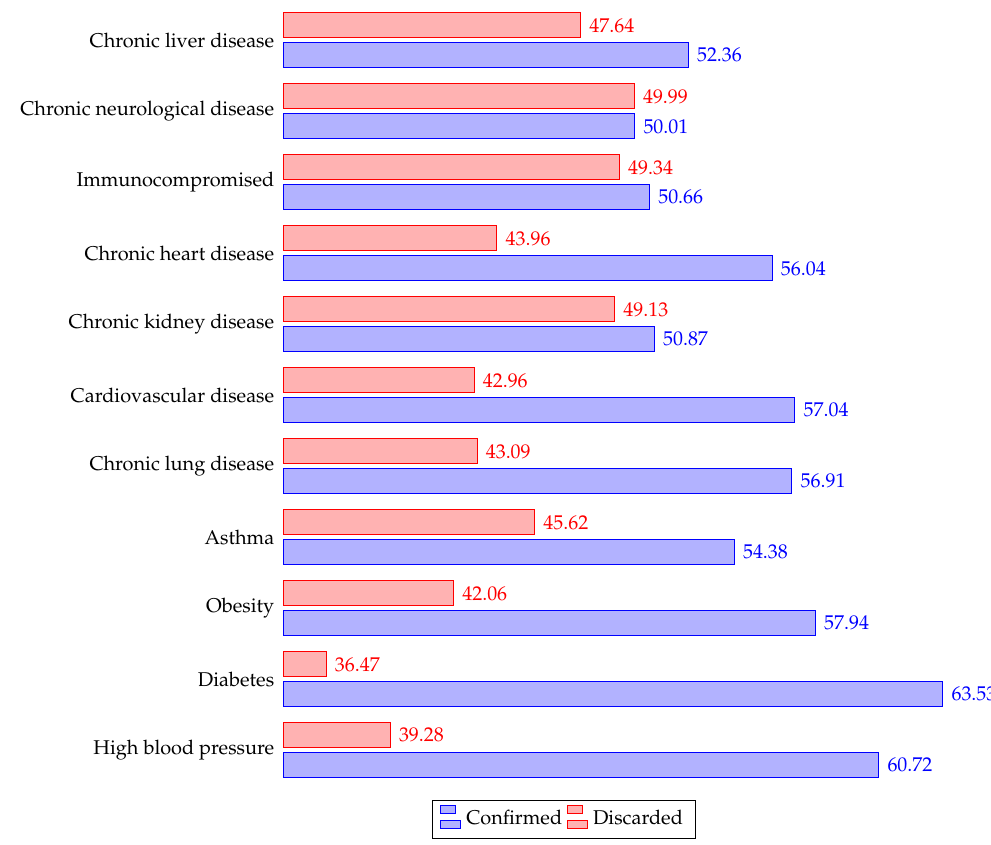
Figure 7. Relative frequency (percentage) of comorbilities in confirmed and discarded patients.